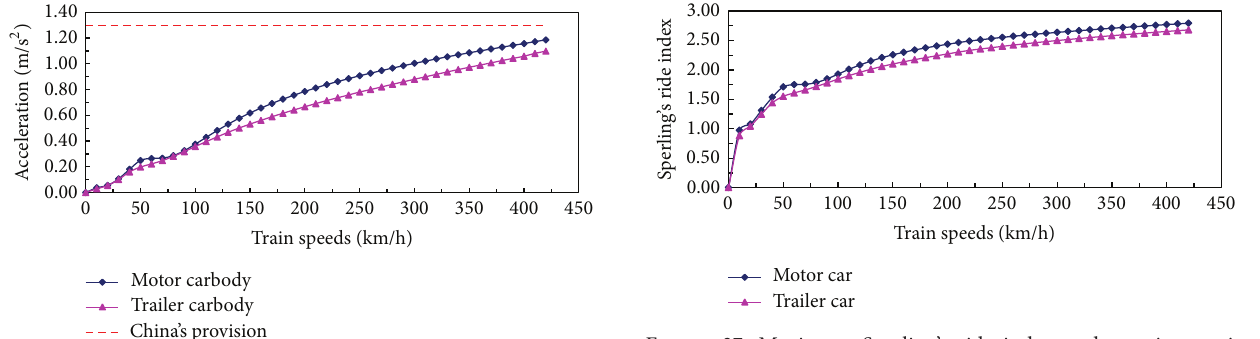
Figure 27: Maximum Sperling’s ride index under various train